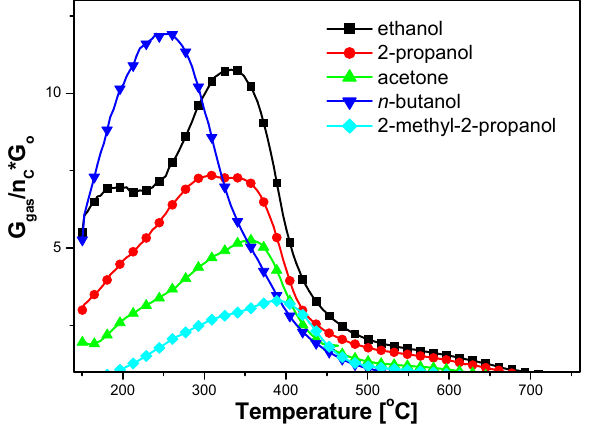
Figure 7. Temperature dependence of sensitivity value divided by the number of carbon atoms in the